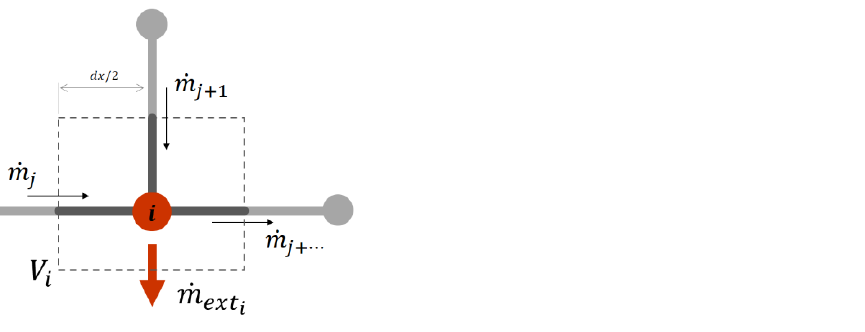
Figure 1. Scheme of the control volume of a general junction between pipelines and consumption node.